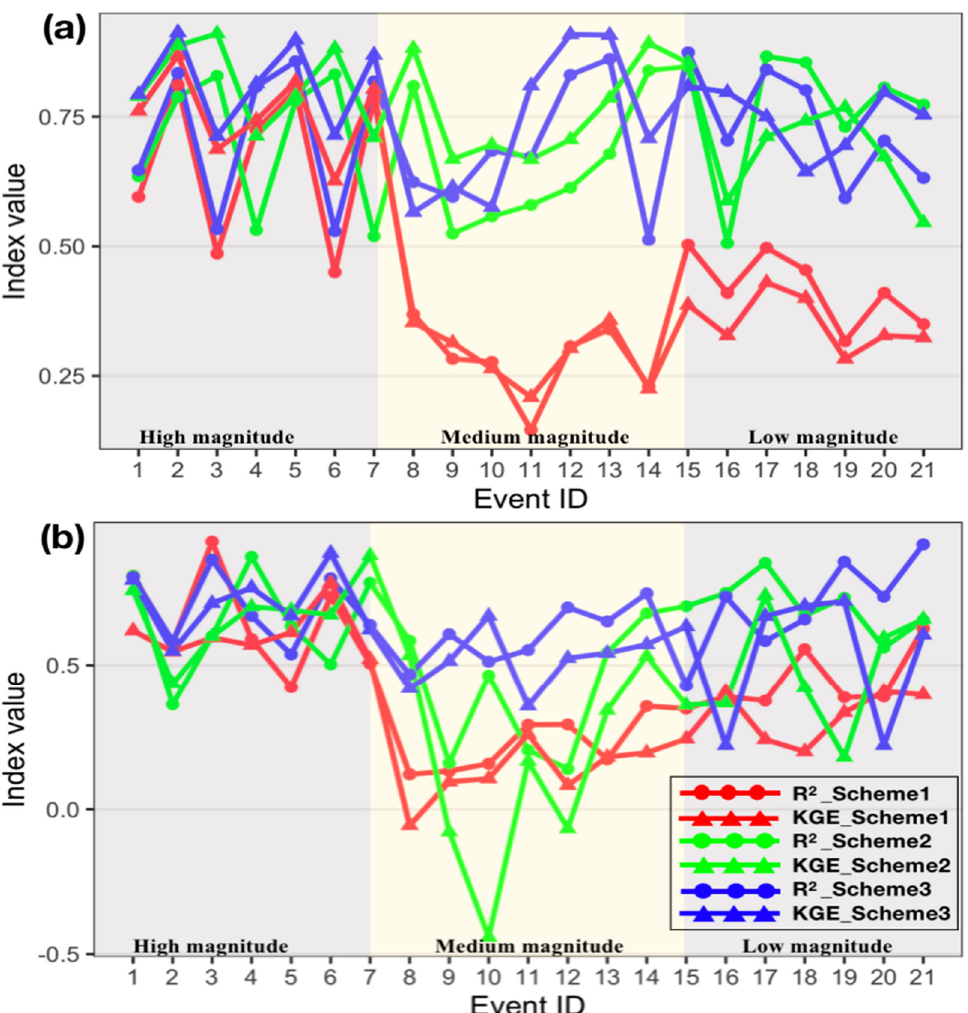
Figure 10. Performance index comparison for the simulations of different magnitude levels of flood events with three different calibration schemes: ( a ) calibration, ( b ) validation.